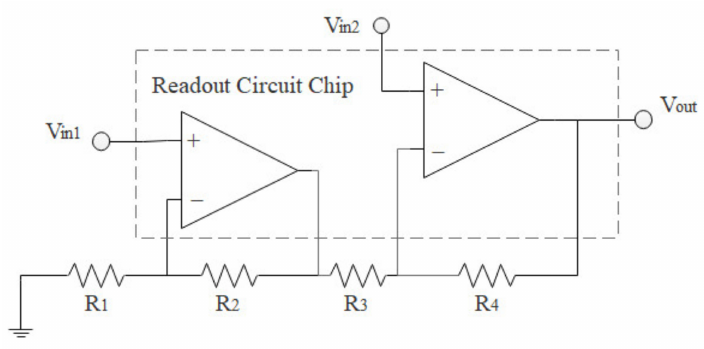
Figure 5. LMV358 is redistributed to serve as a 2-op amp instrumentation